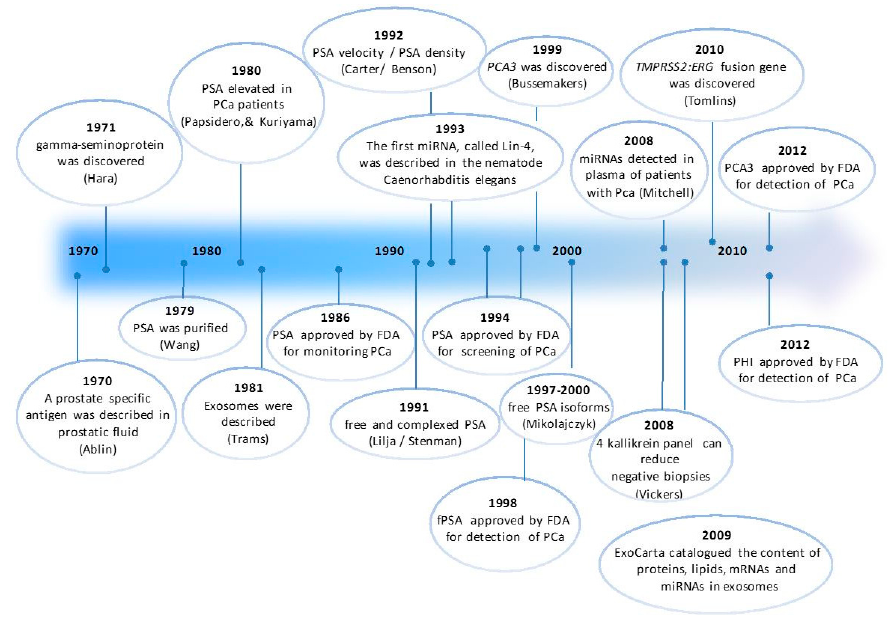
Figure 2. Timeline for the identification of PCa biomarkers. Most important events related to PCa markers from 1970 till the present. PSA: prostate specific antigen, miRNA: microRNA, PCa: prostate cancer, fPSA: free PSA, PHI: prostate health